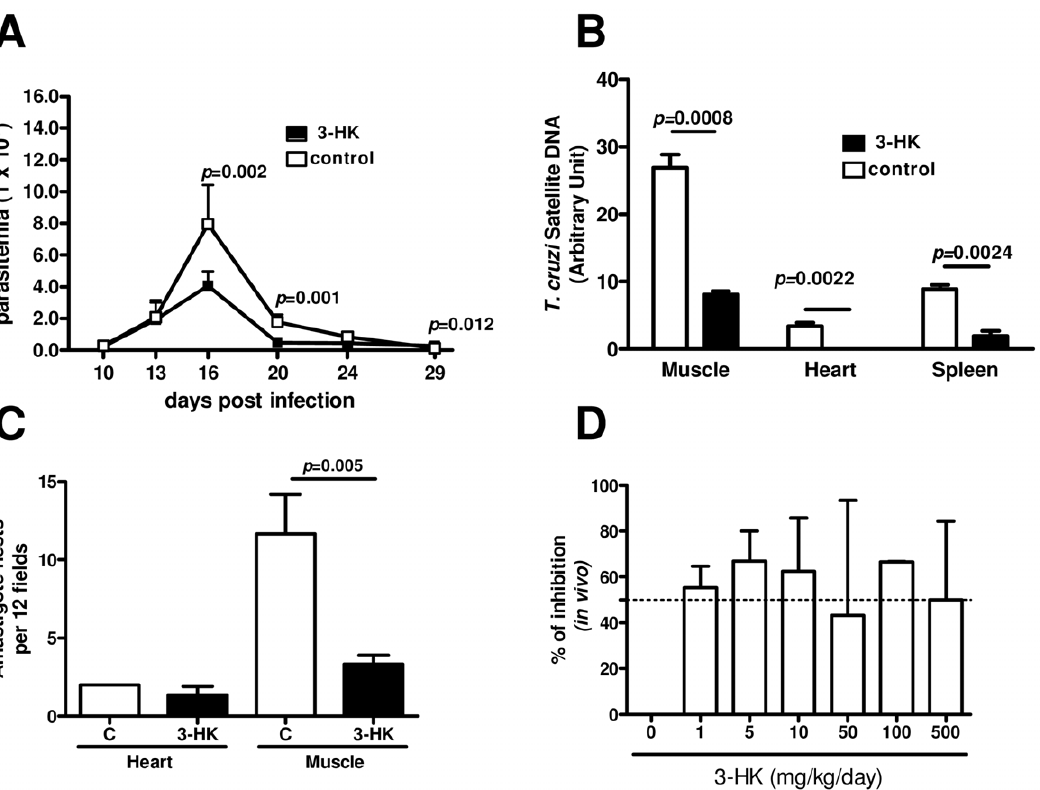
Figure 1. 3-HK treatment controls the parasite load in blood and target tissues. Parasitemia, histological analysis, relative amount of parasite DNA and ED 50 were determined in 500-Tps infected mice treated with 1 mg/kg/day of 3-HK (3-HK) or vehicle (control) from dpi 5 to 10 by the i.p. route. (A) Quantitation of parasitemia (Tps/ml blood). Results are means 6 SD of 6–8 mice/group. (B) Quantitation of the number of nests of amastigotes at 3 levels of heart and skeletal muscle from control ( n= 3) and 3-HK ( n =4) groups at 16 dpi, employing Axio-Vision 3.0.6 software. (C) Relative amount of T. cruzi satellite DNA in the skeletal muscle, heart and spleen from 20-day T. cruzi infected 3-HK and control mice. Murine GAPDH was used for normalization. Data are shown as mean 6 SD of triplicates, n=4 mice per group. (D) Parasitemia (Tps/ml blood) at 16 dpi was recorded in 500-Tps infected mice treated with different 3-HK doses (1, 5, 10, 50, 100 and 500 mg/kg/day) or vehicle. The mean value determined for a group of 6–8 mice was used to calculate the percentage of inhibition in parasitemia respect to the vehicle control group. The percentage of inhibition was calculated as [(C-3-HK)/C] 6 100 where C is the parasitemia in the control group and 3-HK is the parasitemia in the treated group. Results are means 6 SD of 6–8 mice/group. One representative of two experiments is